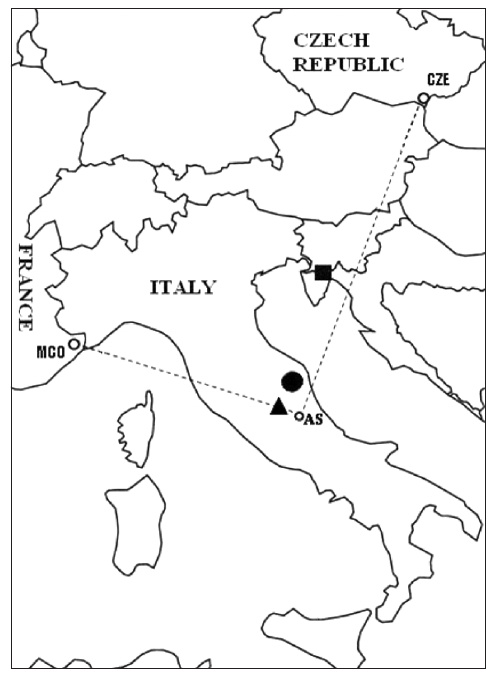
Fig. 2. Map showing the location of the receiver AS and of the two transmitters MCO and CZE. The two radio-paths are indicated by dotted lines. The lo- cation of the Reatini mountains seismogenetic area is shown by a black triangle. The black square rep- resents the location of the Slovenia seismic se- quence, and the black circle indicates the location of the M =5.6 and M =5.9 Umbria-Marche